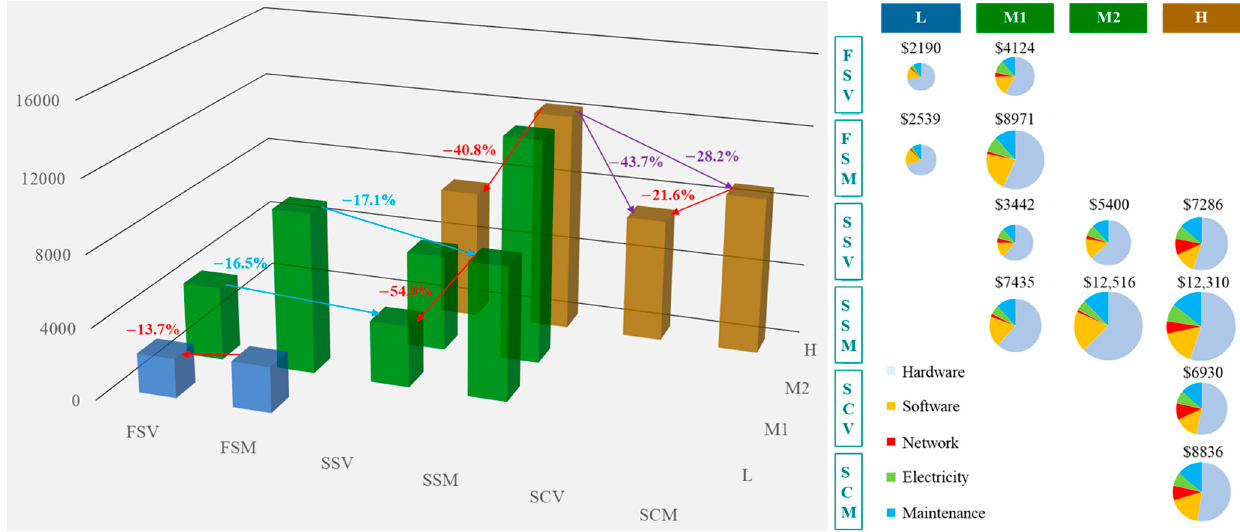
Figure 4. Cost comparison of intelligent driving under different technical routes. Costs are expressed in USD.